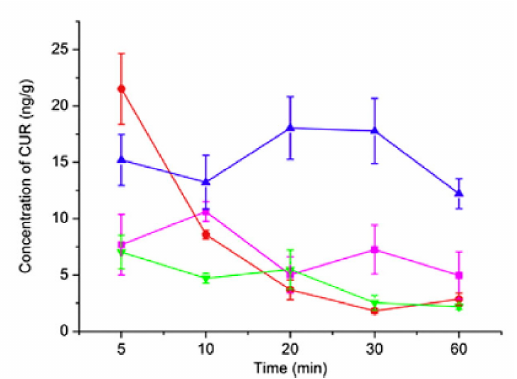
Figure 4. Concentration of different sizes of 2 mg/kg curcumin suspension (CUR-NS) in the brain over time [144] (pink: curcumin solution, red: 20 nm Curcumin-NS, blue: 70 nm CUR-NS and green: 200 nm: CUR-NS). Reproduced from [92] with the permission from